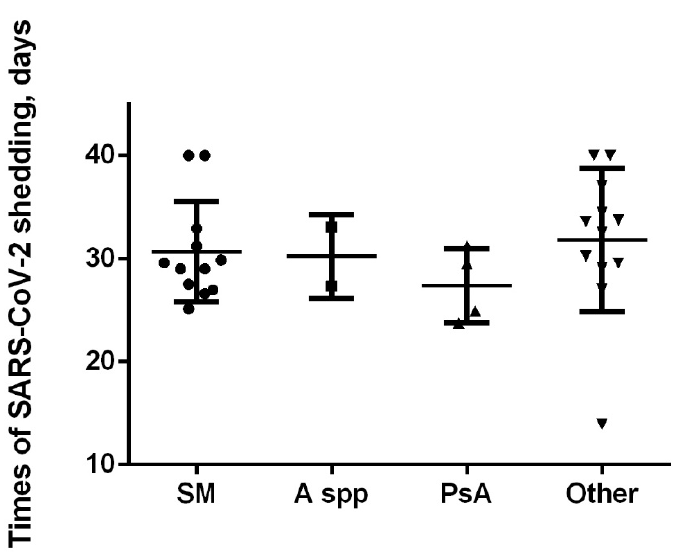
Figure A1. Pathogens isolated from respiratory specimens.